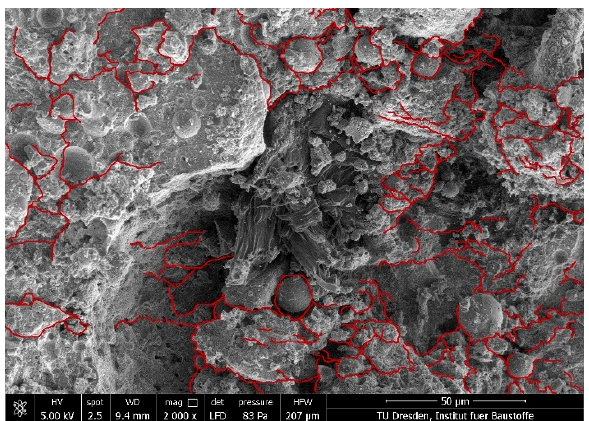
Figure 8. Microcracks in the SHCC matrix after alternating tension-compression loading [7].